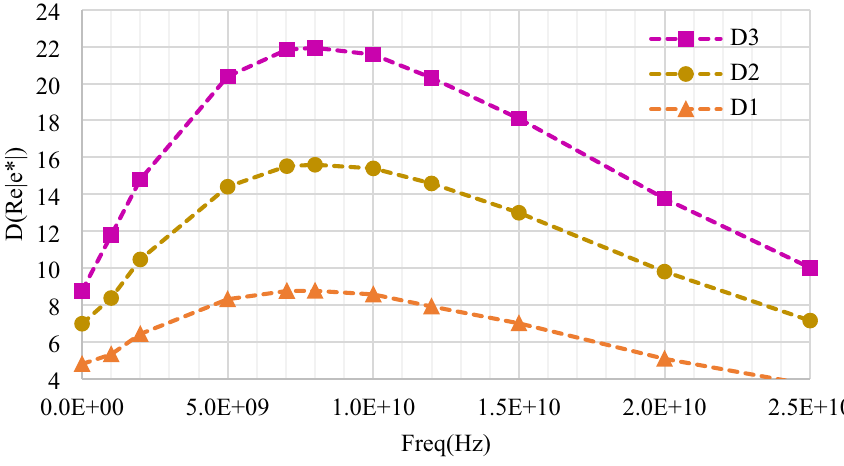
Figure 8. Δ(Re(ε*))(f), Maximum difference in the real part of the permittivity as a function of